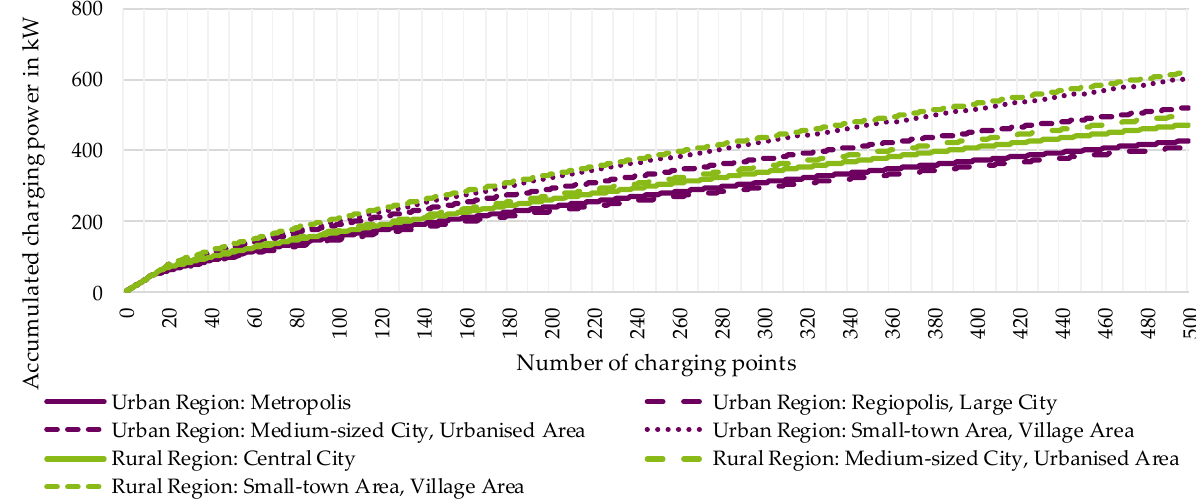
Figure A11. Accumulated charging power in kW for 11 kW charging points up to 500 charging points for seven area types.